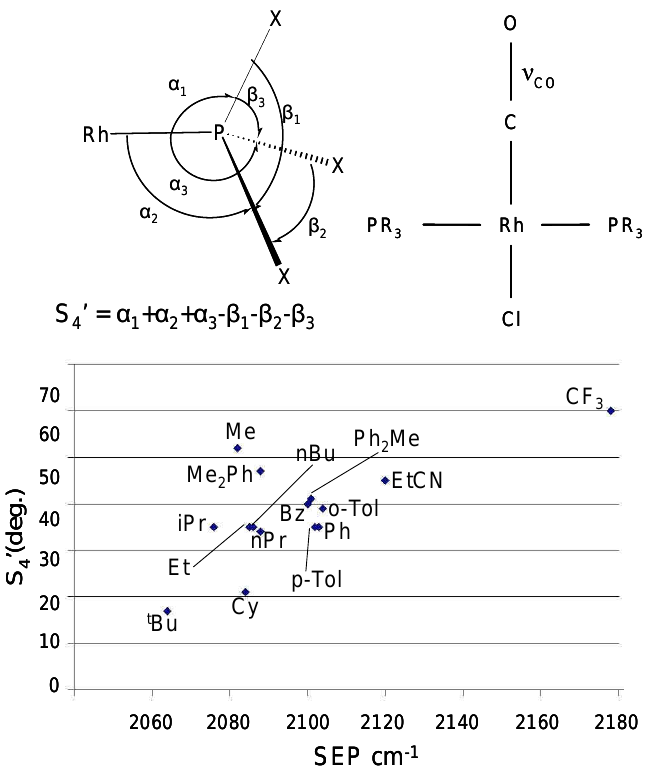
Figure 2 . (top) Descriptors calculated for phosphines in the trans-Rh(PR ) (CO)Cl catalyst (values 3 2 taken from Cooney et al .). The deformation coordinate S ’ is employed as steric measure. For the same 4 PM3(tm)-optimized geometry, the IR spectrum was also calculated yielding the SEP parameter (CO stretching frequency). (bottom) Stereoelectronic map showing the distribution of ligands in the 2- dimensional descriptors